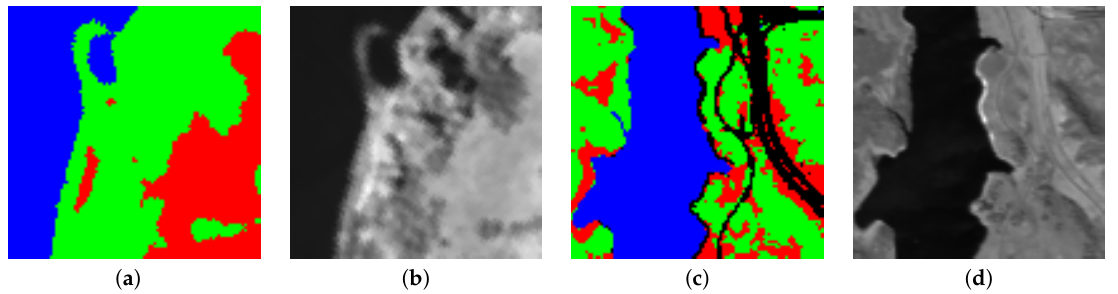
Figure 3. Partitions for ( a ) Samson and ( c ) Jasper Ridge provided by the proposed algorithm (their average bands are also shown in ( b ) and ( d ) for reference). Materials in Figure 3a: Soil (red), Tree (green), and Water (blue). Materials in Figure 3c: Road (black), Soil (red), Water (blue), and Tree